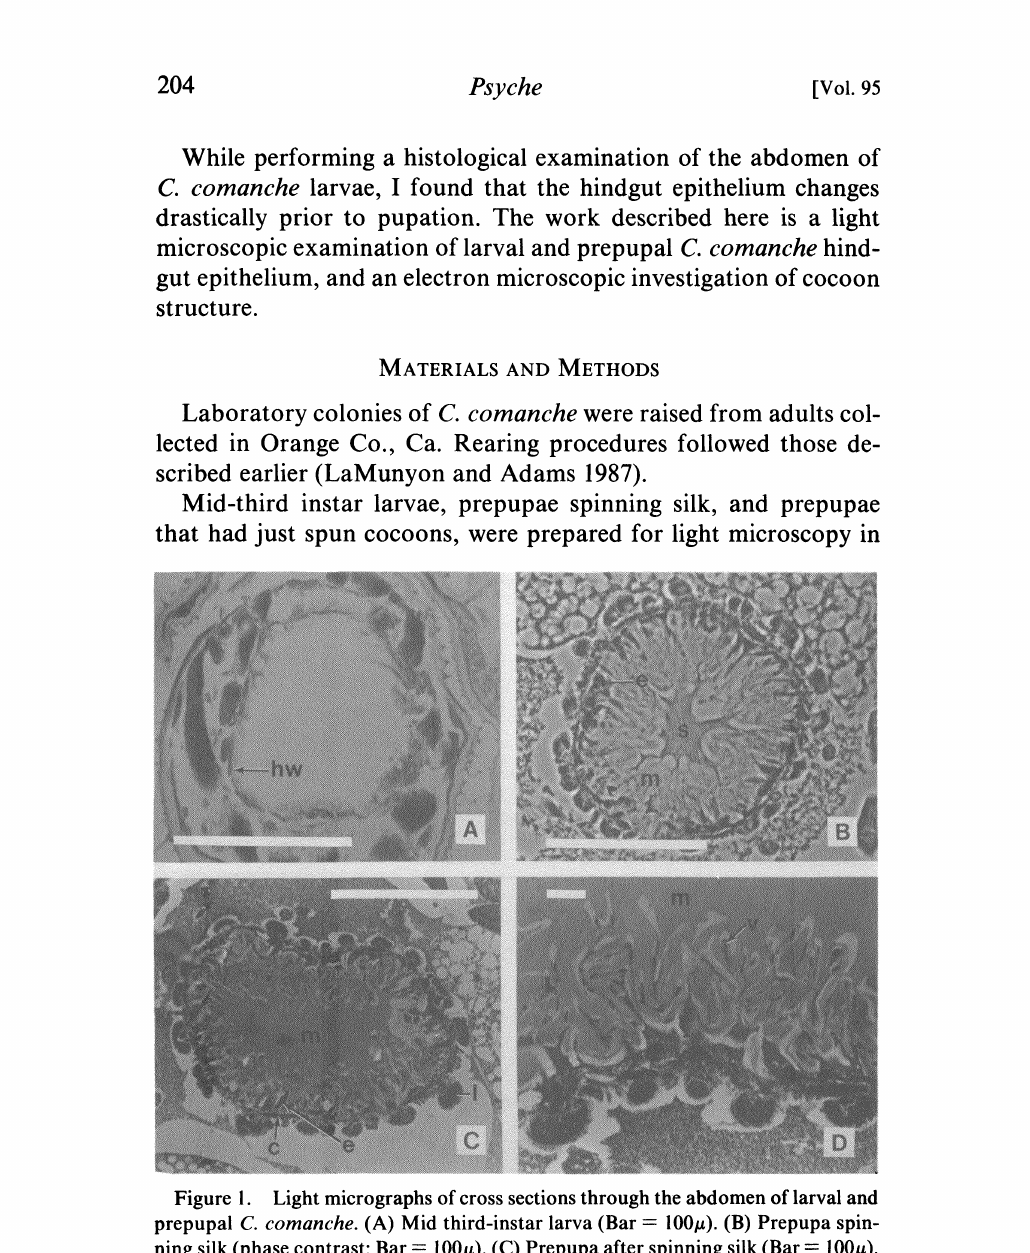
Figure 1. Light micrographs of cross sections through the abdomen of larval and prepupal C. comanche. (A) Mid third-instar larva (Bar 100). (B) Prepupa spin- ning silk (phase contrast; Bar 100/). (C) Prepupa after spinning silk (Bar